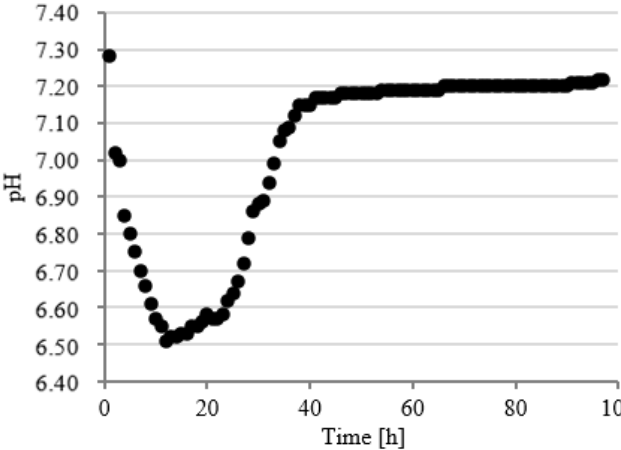
Figure 12. Course of pH changes in series 5.